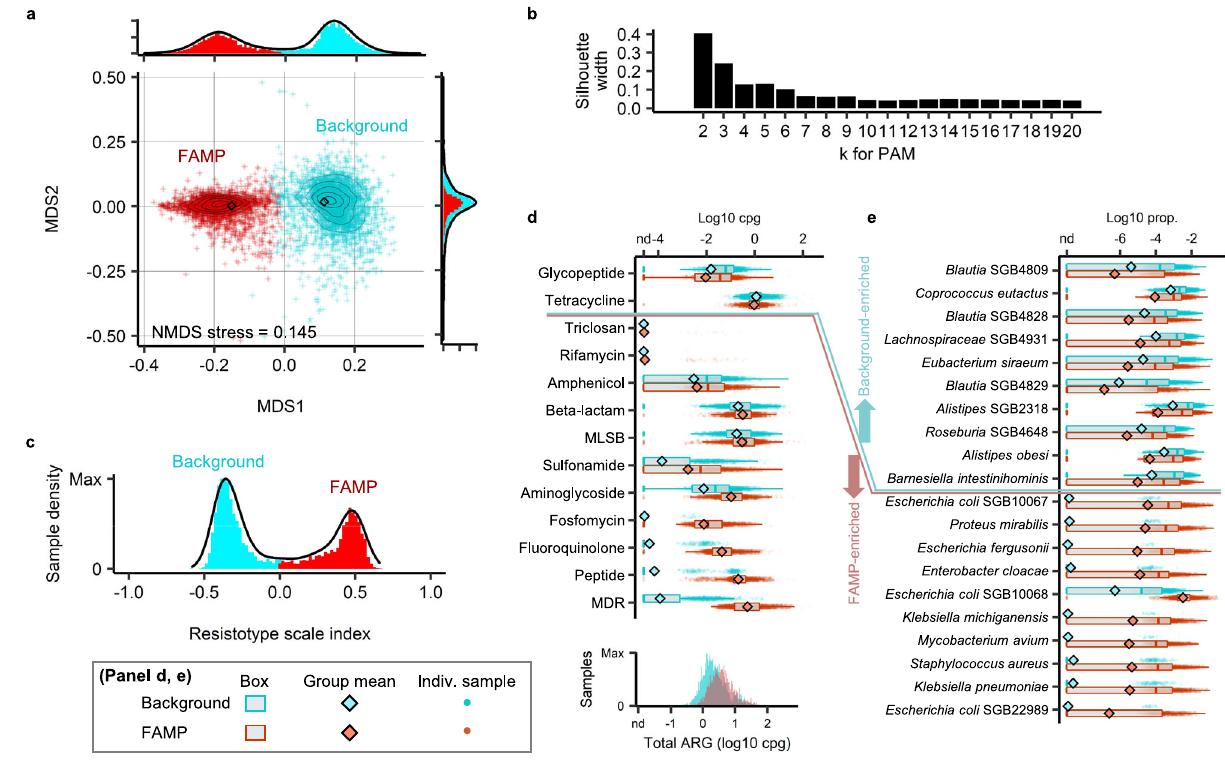
Fig. 3 | Two distinct clusters apparent in the global landscape of adult gut resistome pro fi les. a NMDS projection of Bray – Curtis dissimilarities among the log-transformed ARG family pro fi les (cpg) in adult gut metagenomes (contours estimate sample densities). Samples were colored by cluster assignment (PAM, Bray-Curtisclustering, k =2). b AveragesilhouettewidthofPAMBray-Curtisclusters asa function of cluster number k . c Sample density projecting points onto the line joining cluster medoids using Bray – Curtis dissimilarities. d Box plots of the sum- med abundance of ARGs in each antibiotic class, separated by resistotype (`back- ground' or `FAMP') with the distribution of total ARGs (cpg) by resistotype shown at the bottom. e Relative abundances of the ten species with highest mean fold difference between resistotypes and two-sided Mann – Whitney